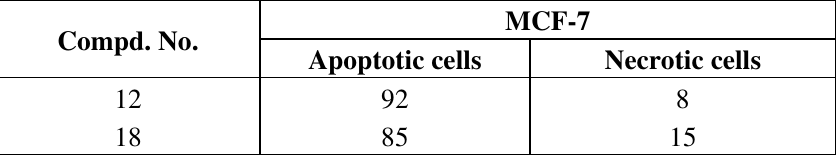
Table 3. Apoptosis and necrosis assay for cytotoxic compounds only.